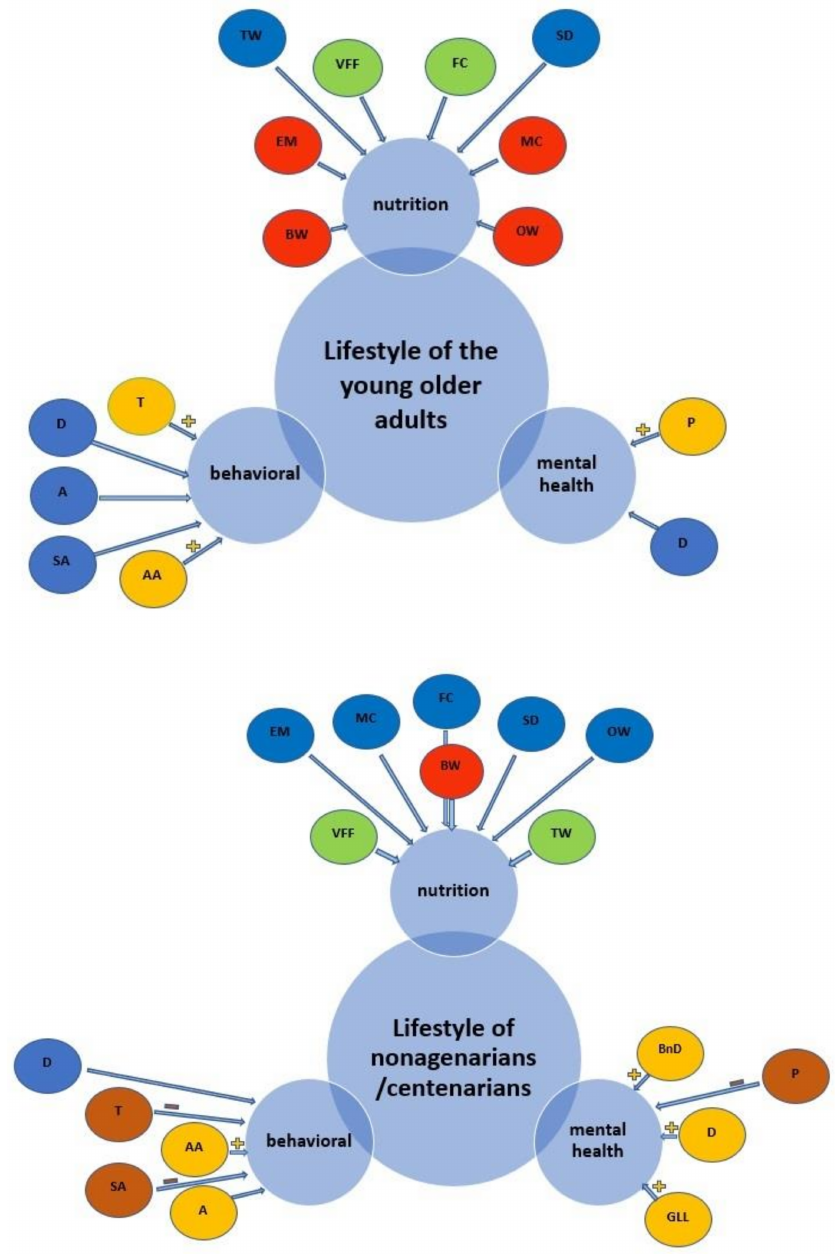
Figure 2. Structural patterns of young older adults’ and nonagenarians/centenarian’ associations with